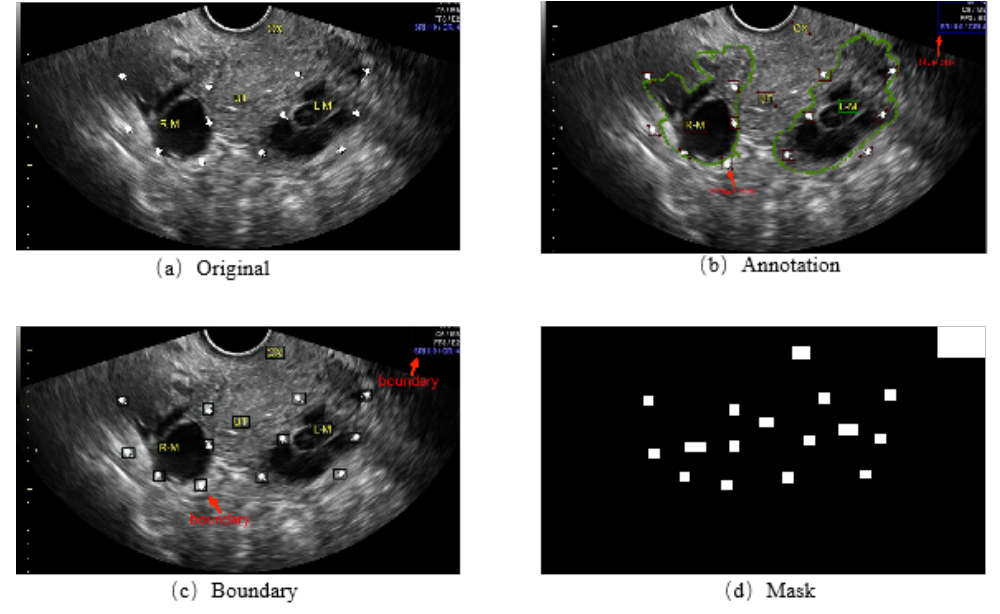
Figure 4. The pipeline of mask generation. ( a ) The original image. ( b ) The annotation. ( c ) The boundary. ( d ) The